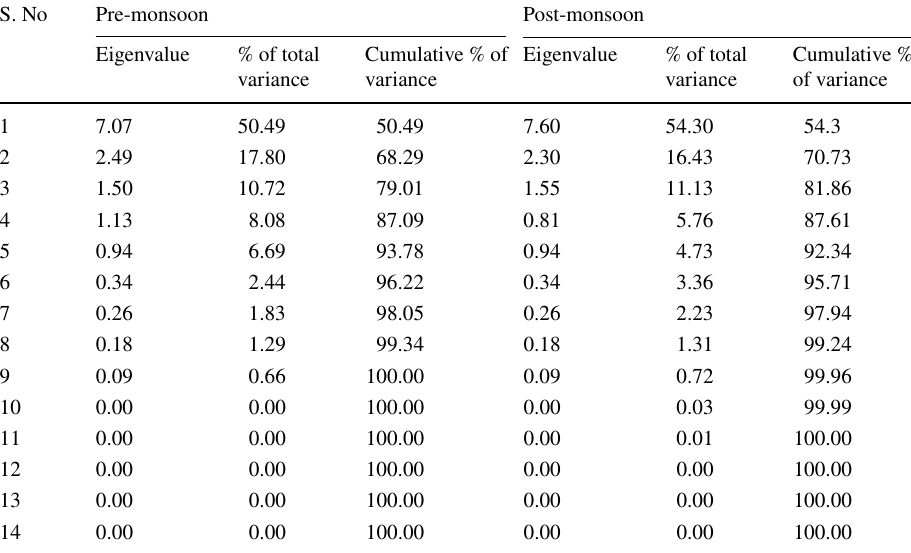
Table 10 Eigenvalue and cumulative contribution of all PCs for pre- and post-monsoon